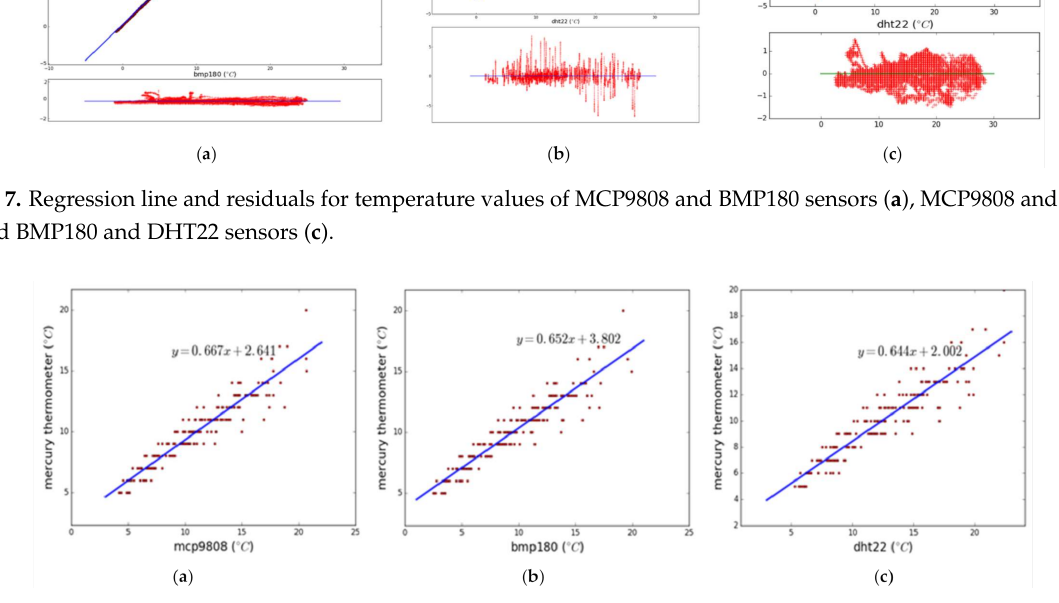
Figure 8. Regression lines for each sensor values MCP9808 ( a ), BMP180 ( b ), DHT22 ( c ), and a mercury thermometer. Table 1. Mean and standard deviation of differences of paired values between mercury thermometer and each